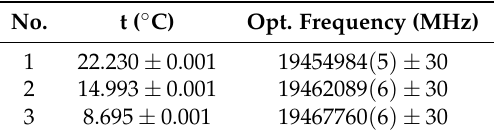
Table 1. List of measured data points (t-diode case